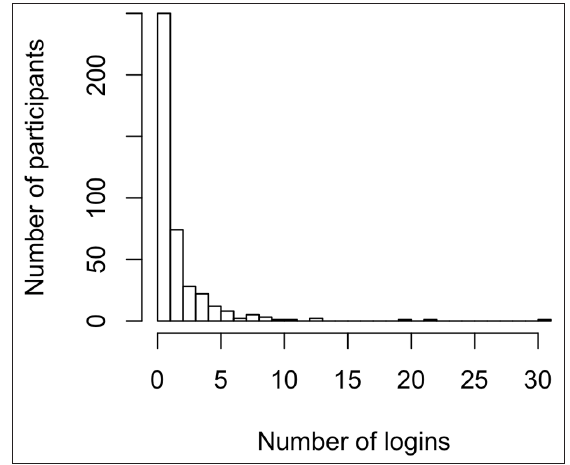
Figure 3: Number of logins by individuals over 8-week study period. Logins are distributed as a Zipf curve. Table 3: Pre-test scores. Scores on pre-test for the three categories of tests using all participants who